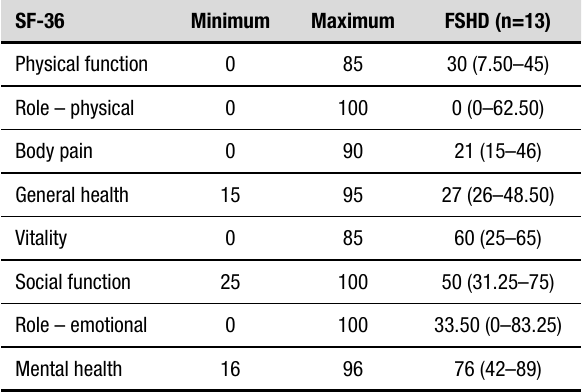
Table 3. Descriptive analysis of quality of life scores in the facioscapulohumeral muscular dystrophy